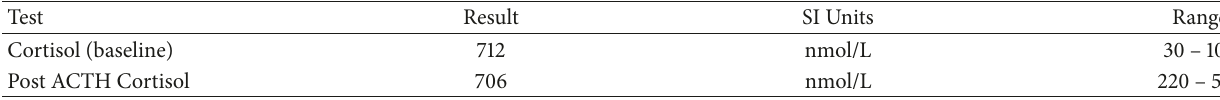
Table 2: Results of the ACTH Stimulation Test ∗ .